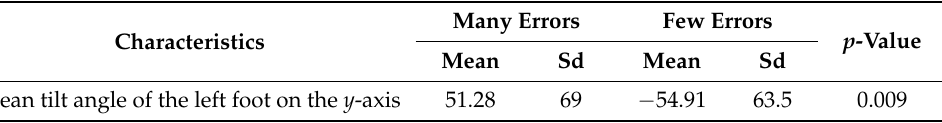
Table 4. Dual tasks performance of NCS and CS groups.